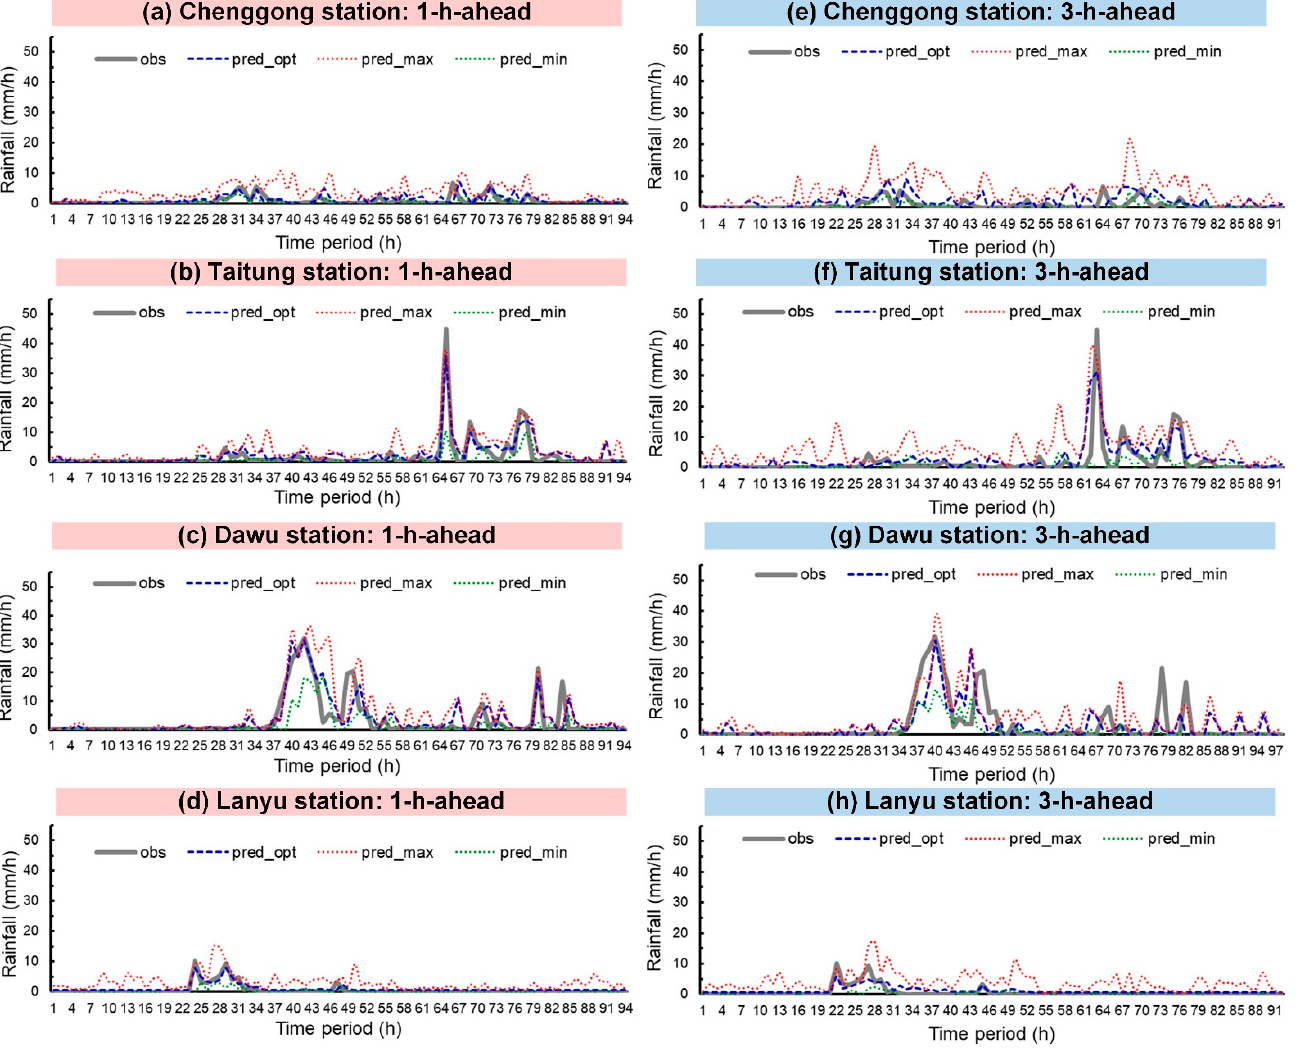
Figure 10. Typhoon Megi prediction results: ( a – d ) lead time = 1 h; ( e – h ) lead time = 3 h. Figure 12 plots the average RMSE and rRMSE for all test typhoons. Figure 12a plots the absolute RMSE performance of pred_opt at the four stations, indicating that (1) for onshore stations, Chenggong station exhibited higher performance than Taitung and Dawu stations did and (2) Lanyu station performed far lower than Chenggong, Taitung, and Dawu stations did. Figure 12b presents the rRMSE performance of pred_opt at the four stations, among which (1) for onshore stations, Chenggong station outperformed Taitung and Dawu stations, (2) Lanyu station outperformed Taitung and Dawu stations, and (3) Lanyu station performed more favorably at lead time = 1 h, but less favorably at lead time = 3 and 6 h than Chenggong station